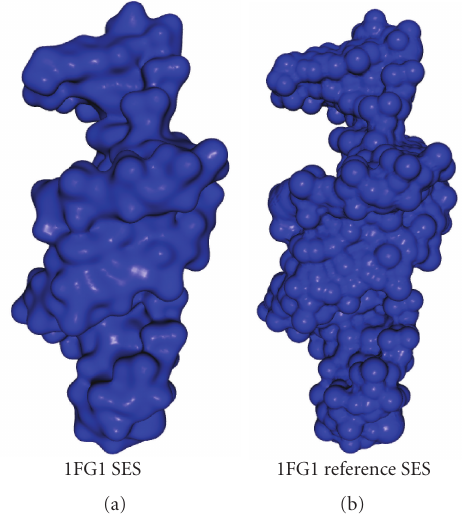
Figure 11: Visual comparison between the 1FG1 SES generated with the FDM algorithm with a spacing of r s / 4 and the reference SES generated with a spacing of r s /